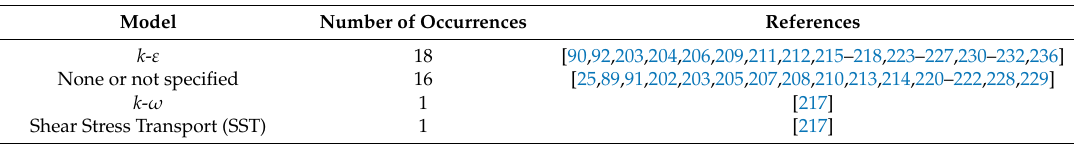
Table 9. Turbulence